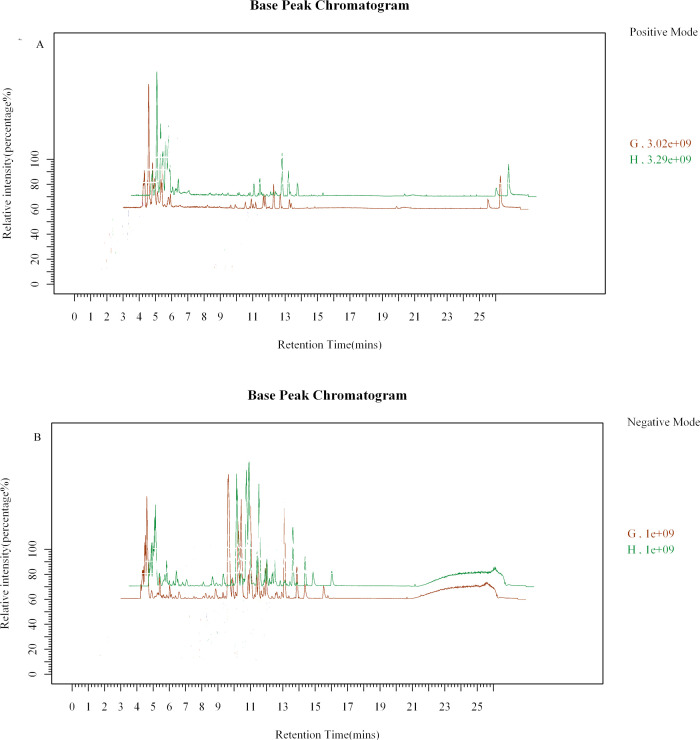
Chromatogram in total ion mode.3-A: Typical Sample BPC in Positive Ion Mode, 3-B: Typical Sample BPC in Negative Ion Mode.